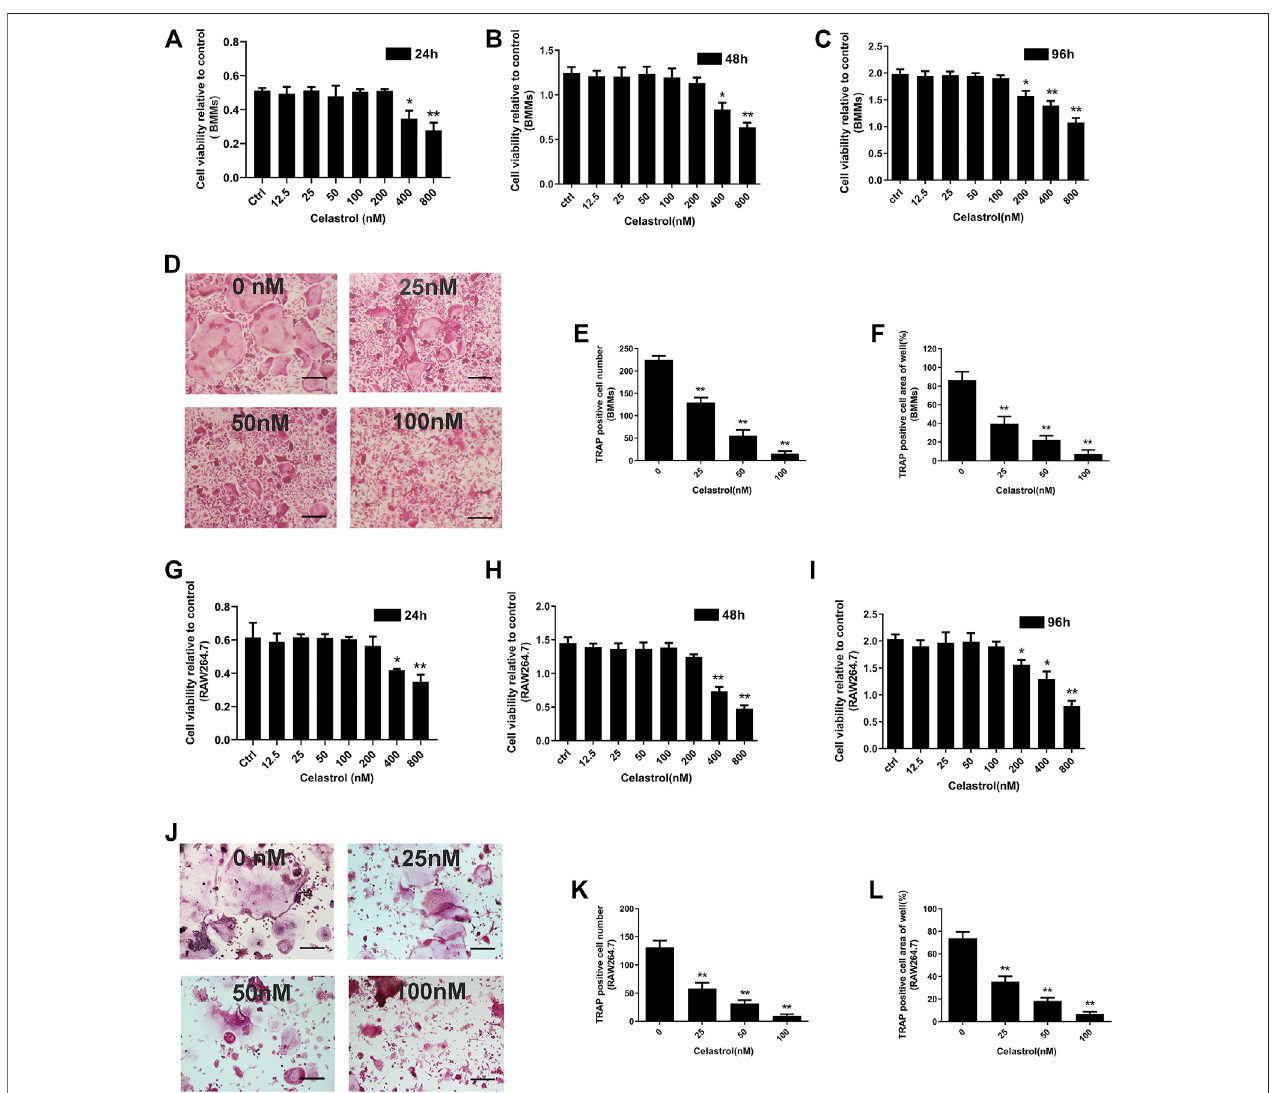
FIGURE 1 | The effect of celastrol on RANKL-induced osteoclast formation had no inhibitory effect on viability in the long-term evaluation. (A-C) Effect of the speci fi edconcentrationscelastrolontheviabilityofbone marrow monocytes/macrophages(BMMs)at24, 48,and96 h, asmeasured byCCK-8 assay. (D) BMMs were treated with 0, 25, 50, and 100 nM celastrol in the presence of 30 ng/mL M-CSF and 50 ng/ml RANKL stimulation for 5 days. The cells were then fi xed with 4% paraformaldehyde and subjected to TRAP staining. Scale bar (cid:2) 200 μ m. (E-F) TRAP-positive cells (number of nuclei ≥ 3) of BMMs cells the numbers and areas of them were quanti fi ed. (G-I) Effect of the speci fi ed concentrations of celastrol on the viability of RAW264.7 cells at 24, 48, and 96 h, as measured by CCK-8 assay. (J) RAW264.7 cells were treated with 0, 25, 50, and 100 nM celastrol in the presence of 50 ng/ml RANKL stimulation for 5 days. The cells were then fi xed with 4% paraformaldehyde and subjected to TRAP staining. Scale bar (cid:2) 200 μ m. (K-L) TRAP-positive cells (number of nuclei ≥ 3) of RAW264.7 cells the numbers and areas of them were quanti fi ed. All experiments were carried out three times, and all data are showed as the means ± SD; * p < 0.05, ** p < 0.01.